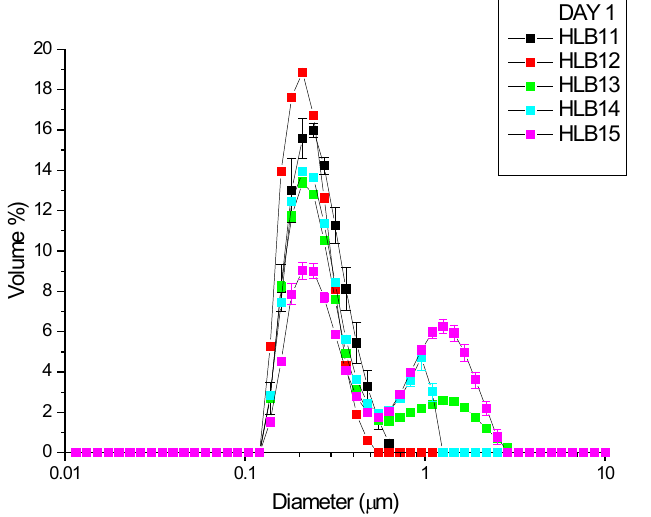
Figure 1. Droplet size distributions for emulsions formulated with 5 wt% lemon oil as a function of surfactant-mixture HLBs.